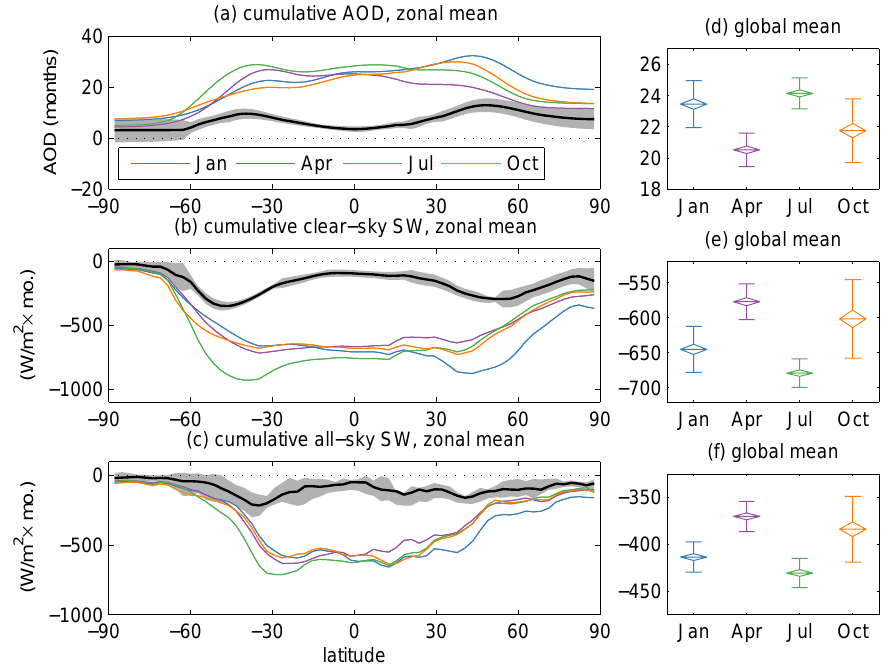
Fig. 10. As Fig. 5, for the E700 experiment. Note different